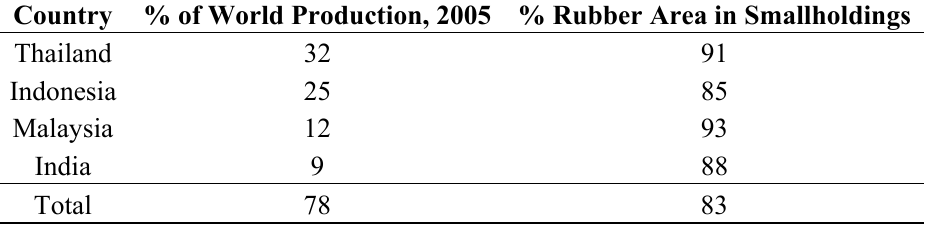
Table 1. Percent of world rubber production and share area under smallholdings, in circa 2005. Source: [45,50].